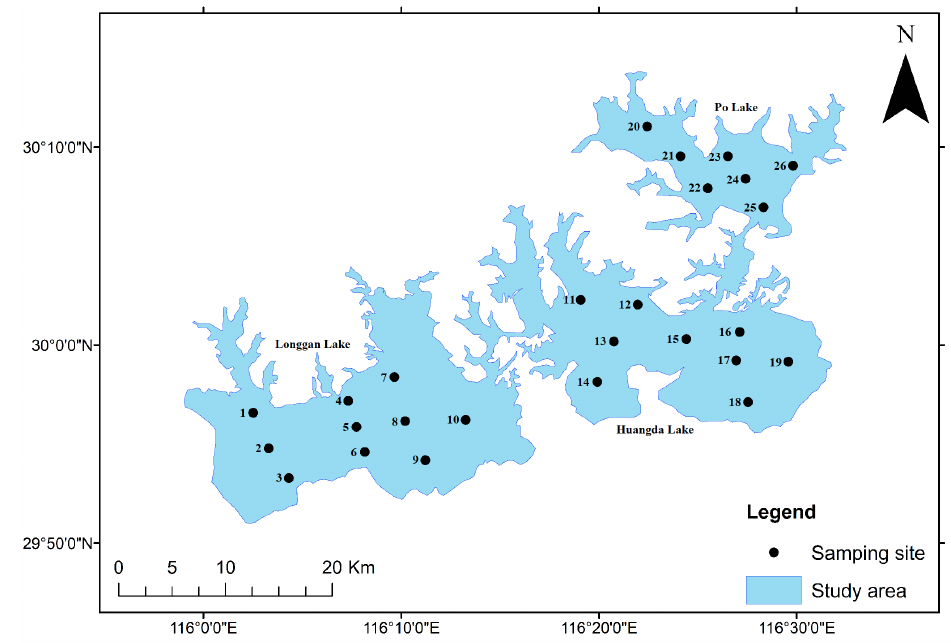
Figure 1. Sampling points of Huayanghe Lake.